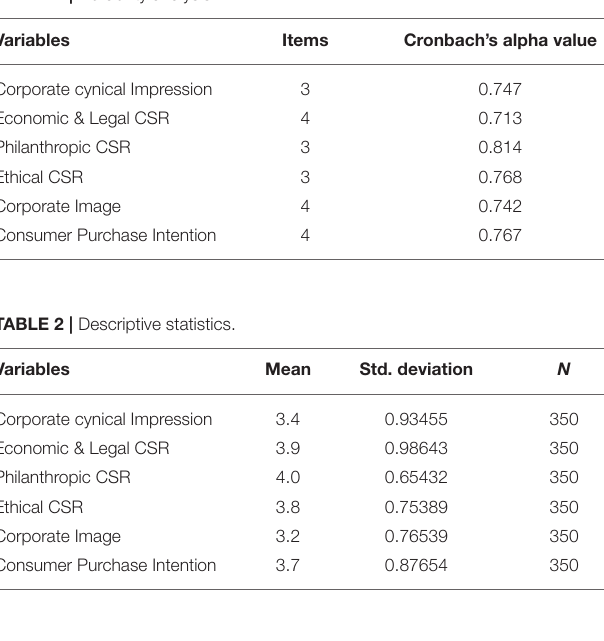
TABLE 1 | Reliability analysis.